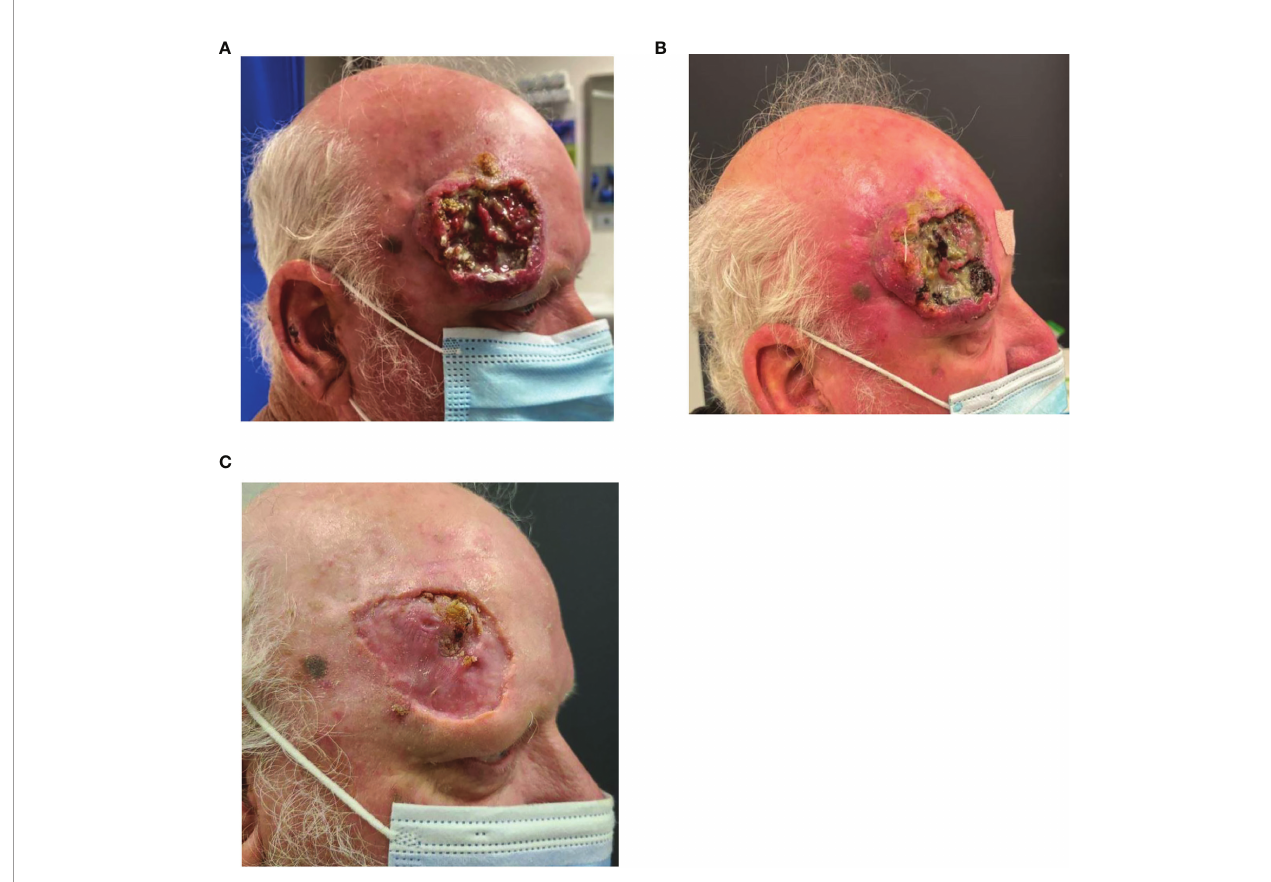
FIGURE 8 | (A) Baseline images of right forehead CSCC. (B) Improvement noted post two cycles of cemiplimab 350 mg/3-weekly and (C) further improvement noted again post cycle